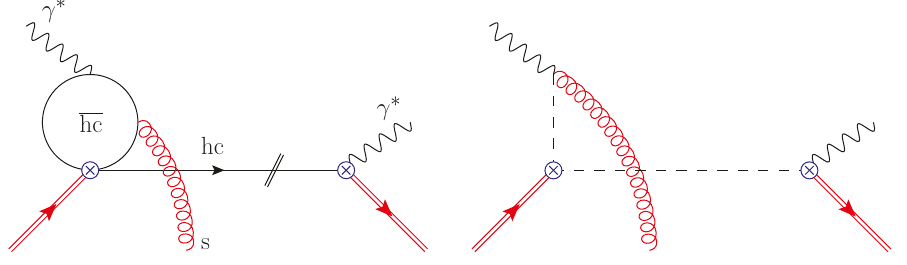
contribution onto SCET O 1 (cid:0) O 7 (cid:13)